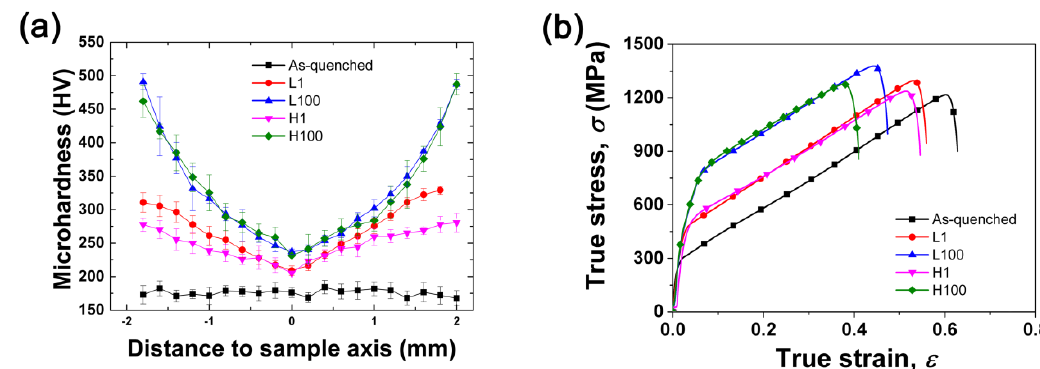
Figure 6. Mechanical properties of various samples: ( a ) Vickers hardness plotted as a function of the distance from the sample axis; ( b ) tensile stress–strain curves. Table 2. Yield strength (YS), peak strength (PS), and uniform elongation (UE) of various